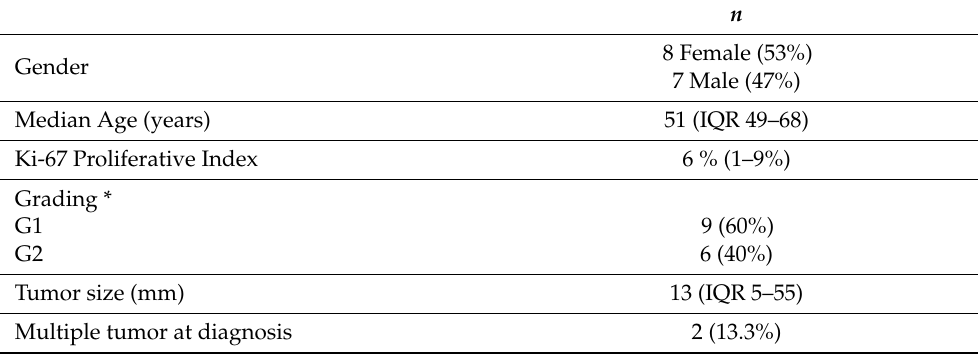
Table 1. Patient Characteristics.